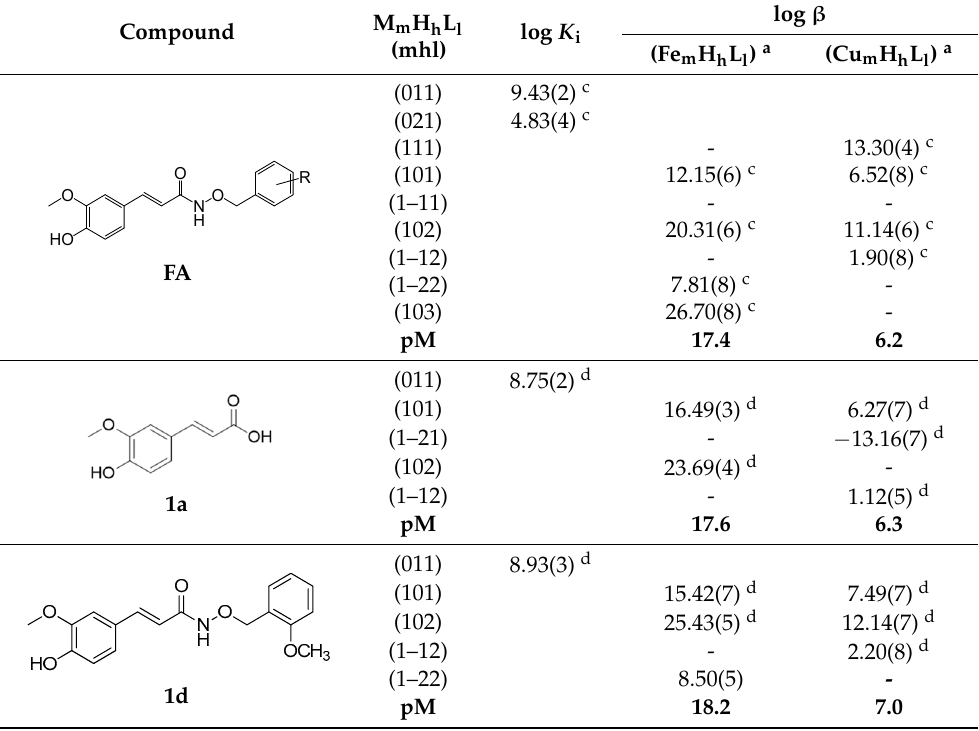
Table 2. Stepwise protonation constants of FA , 1a , and 1d as well as global formation constants a of Table 1. Antioxidant results based on radical scavenging activity using the DPPH method. their Fe 3+ , Cu 2+ complexes and corresponding pM b values. (T = 25.0 ± 0.1 °C, I = 0.1 M KCl, 20% w/w DMSO/water).